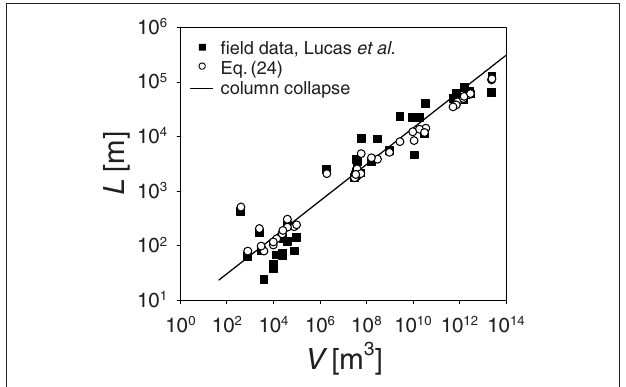
FIGURE 6 | Runout as a function of landslide volume. Full squares are field observations taken from [2]. Open circles denote Equation (24), in which H and V are taken from the same field observations and α thr is 2 R f ( V ) (see Equation 22), i.e., a total spread of a deposit resulting from a granular column collapse.